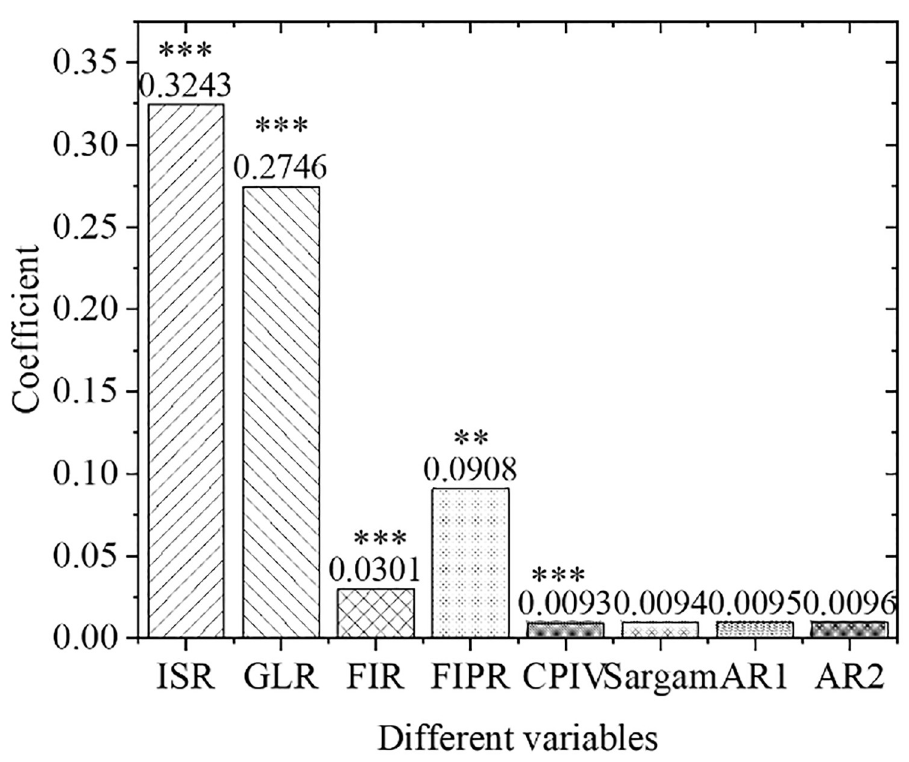
Fig 5. Estimation results of overall empirical panel coefficient. Note: � , �� , and ��� represent the significance level of 10%, 5%, and 1%, respectively, the same below.